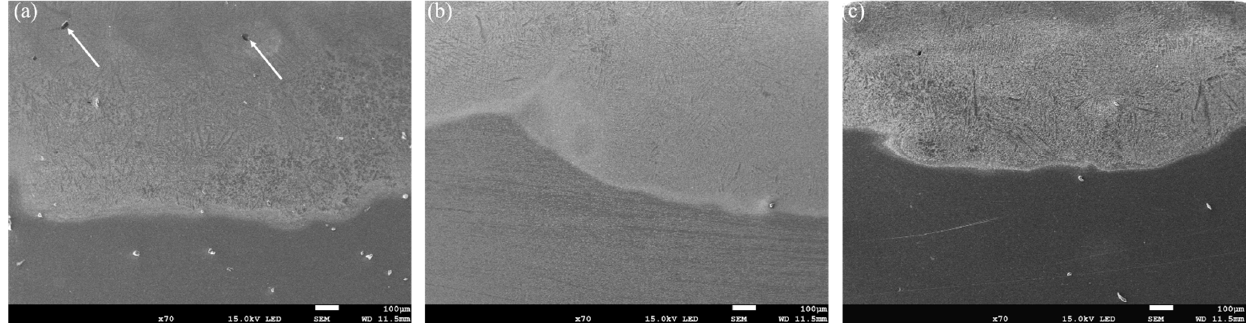
Figure 2. Cross-section morphologies of the coating under different laser scanning speeds: ( a ) ν = 12 mm/s, ( b ) ν = 15 mm/s and ( c ) ν = 18 mm/s.